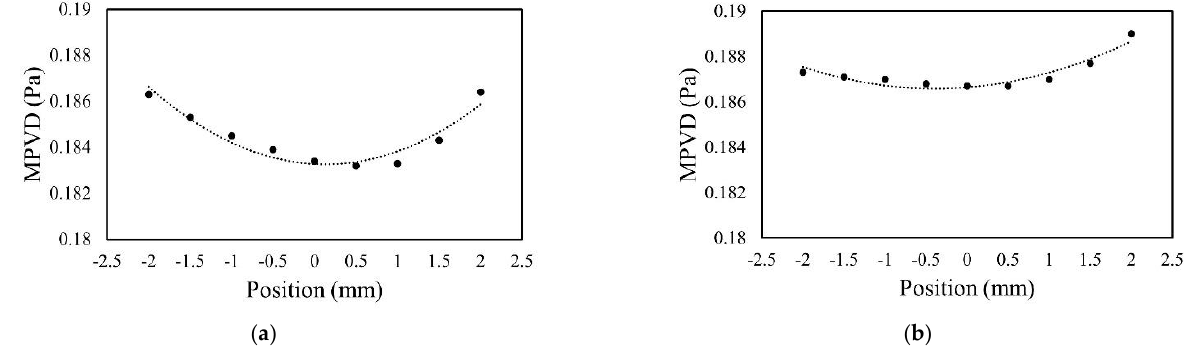
Figure 10. Frequency spectrum in Sector 3 for flake positioned at ( a ) − 2 mm, ( b ) − 1.5 mm, ( c ) − 1 mm, ( d ) − 0.5 mm, ( e ) 0 mm, ( f ) 0.5 mm, ( g ) 1 mm, ( h ) 1.5 mm, and ( i ) 2 mm.